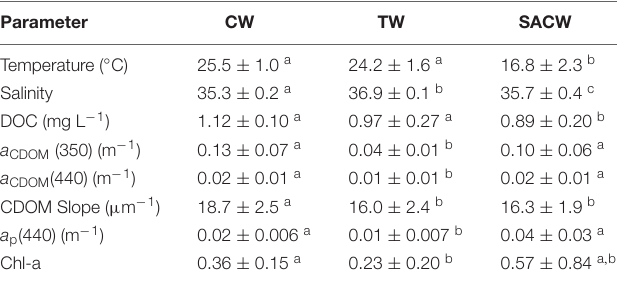
Different (or same) superscript letters (a, b, or c) indicate significant difference (p < 0.05) (or no difference, p > 0.05) of the corresponding mean variable between the water masses domains (based on Kolmogorov–Smirnov